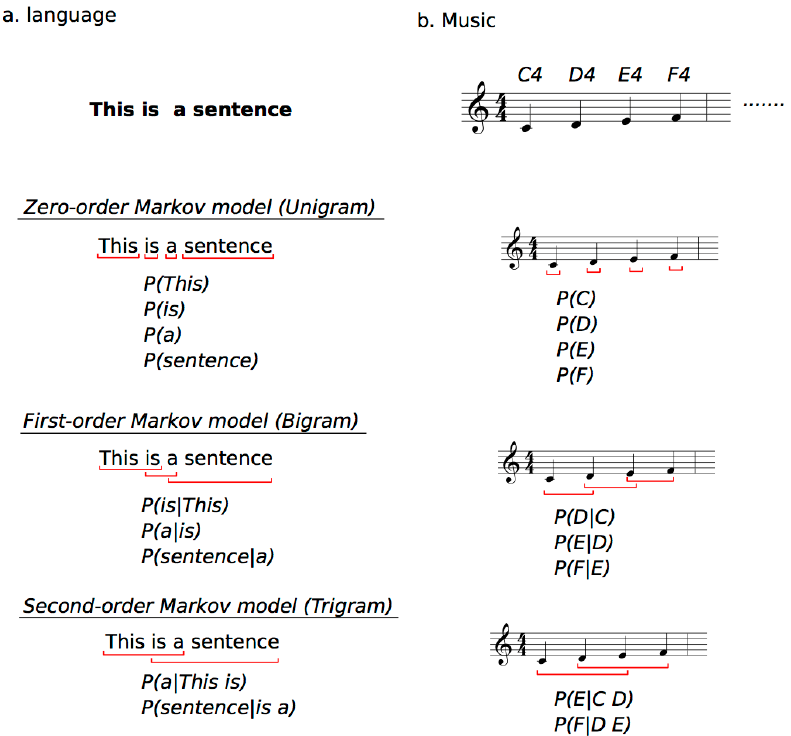
Figure 1. Example of n -gram and Markov models in statistical learning (SL) of language ( a ) and music ( b ) based on information theory. The top are examples of sequences, and the others explain how to calculate TPs ( P ( e n +1 | e n )) based on zero- to second-order Markov models. They are based on the conditional probability of an event e n +1 , given the preceding n events based on Bayes’ theorem. For instance, in language (( a ), This is a sentence), the second-order Markov model represents that the “a” can be predicted based on the last subsequent two words of “This” and “is”. In music (( b ), C4, D4, E4, F4), second-order Markov model represents that the “E” can be predicted based on the last subsequent two tones of “C” and “D”.